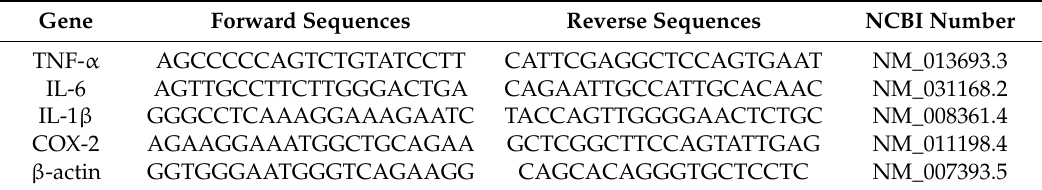
Table 1. Primer information for real-time